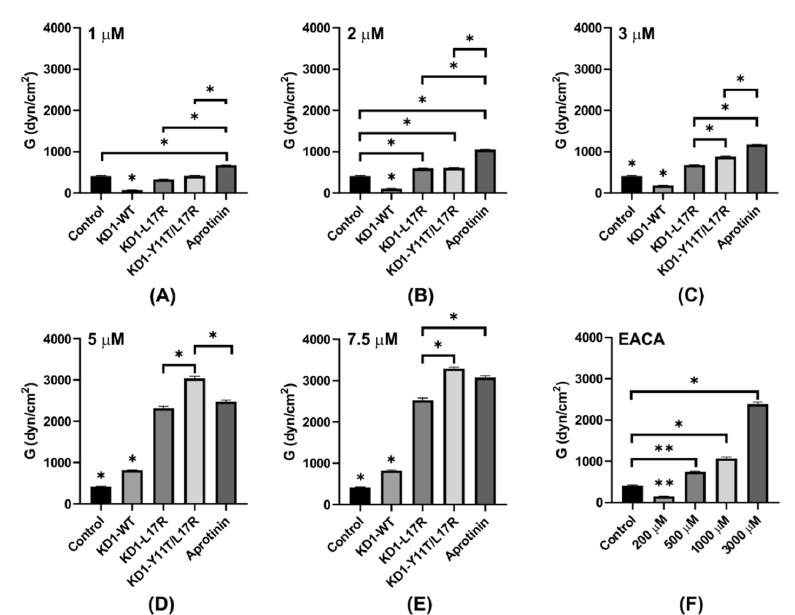
Figure 9. Comparison of shear elastic modulus strength (G, TEG experiments) for KD1-WT, KD1-L17R-K COOH , KD1-Y11T / L17R-K COOH , aprotinin and EACA at di ff erent concentrations. Bar graphs represent the ‘G’ achieved with KD1-WT, KD1-L17R-K COOH , KD1-Y11T / L17R-K COOH , aprotinin and EACA at di ff erent concentrations. Panel ( A ), 1 µ M; panel ( B ), 2 µ M; panel ( C ), 3 µ M; panel ( D ), 5 µ M; panel ( E ), 7.5 µ M; and panel ( F ), 200 µ M to 3000 µ M EACA. All experiments were performed in duplicate and the mean ± SD values are presented. Note: The * without bar represents significant di ff erence from all other agents listed. The * indicates p < 0.05 and ** indicates p < 0.01.